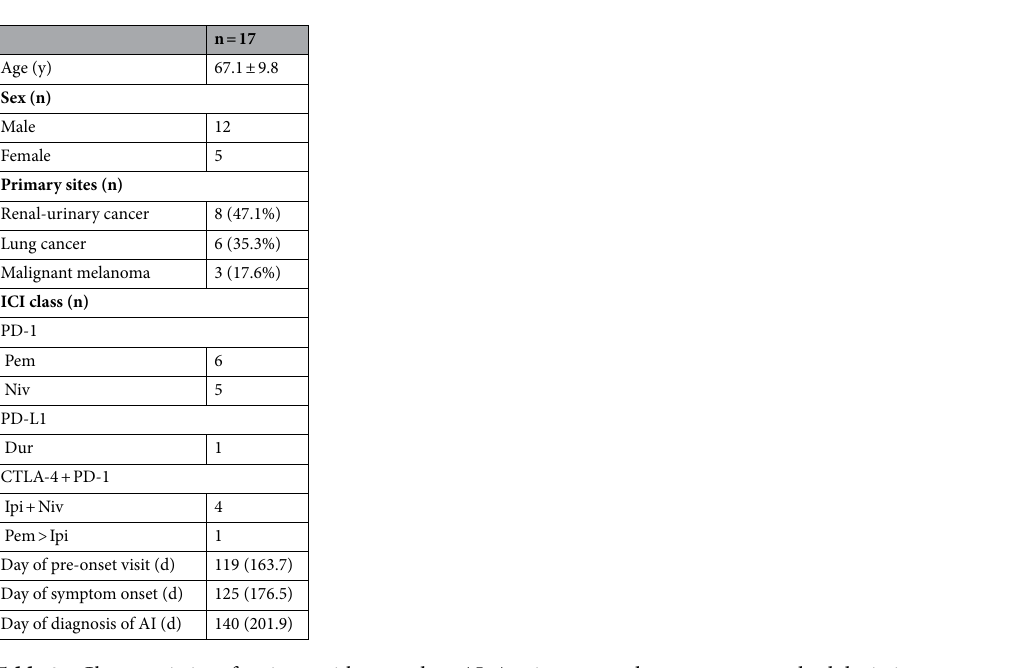
Table 3. Characteristics of patients with secondary AI. Age is expressed as average ± standard deviation at diagnosis. Pem > Ipi indicates change of immune checkpoint inhibitor from pembrolizumab to ipilimumab. ‘Day’ is expressed as the median (average) number of days from the first administration of ICI. Abbreviation: CTLA-4 cytotoxic T-lymphocyte-associated protein 4, Dur durvalumab, ICI immune checkpoint